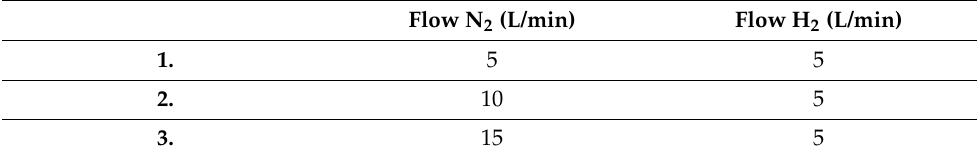
Table 3. Gas flows in the experiment.